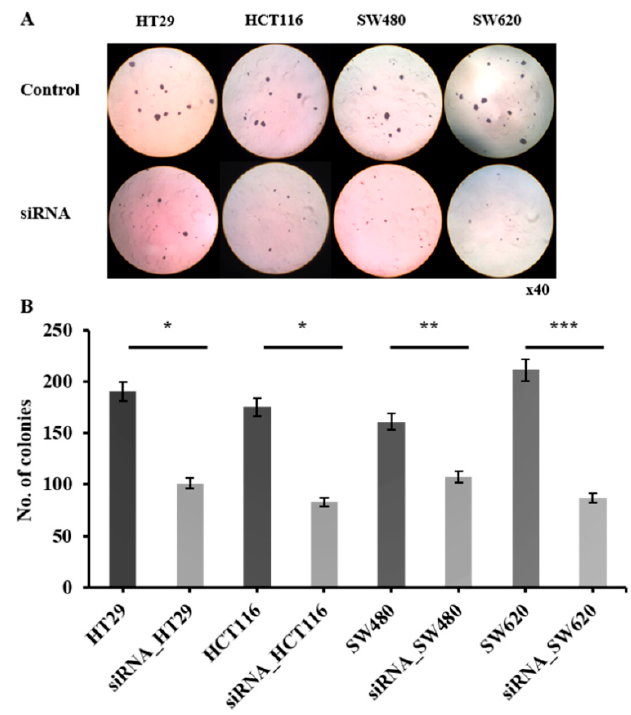
Figure 6. HJURP depletion impairs anchorage-independent colony forming ability of colorectal cancer cell lines in vitro. Control or HJURP-siRNA colorectal cancer cell lines were seeded on soft agarose and incubation was done for 14 days to evaluate colony forming ability. ( A ) Representative images of colonies were shown ( × 40). ( B ) Number of colonies from each colorectal cancer cell lines were quantified (HT29; * p = 0.038, HCT116; * p = 0.05, SW480; ** p = 0.008, SW620; *** p = 0.001).